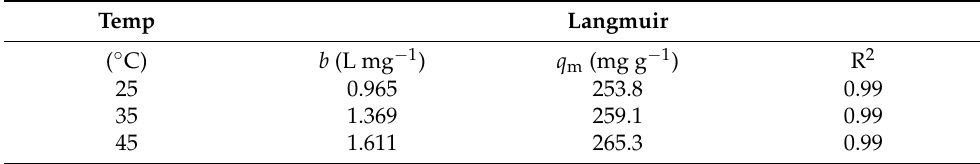
Table 2. Langmuir constants of NiCo 2 O 4 /MWCNTs.